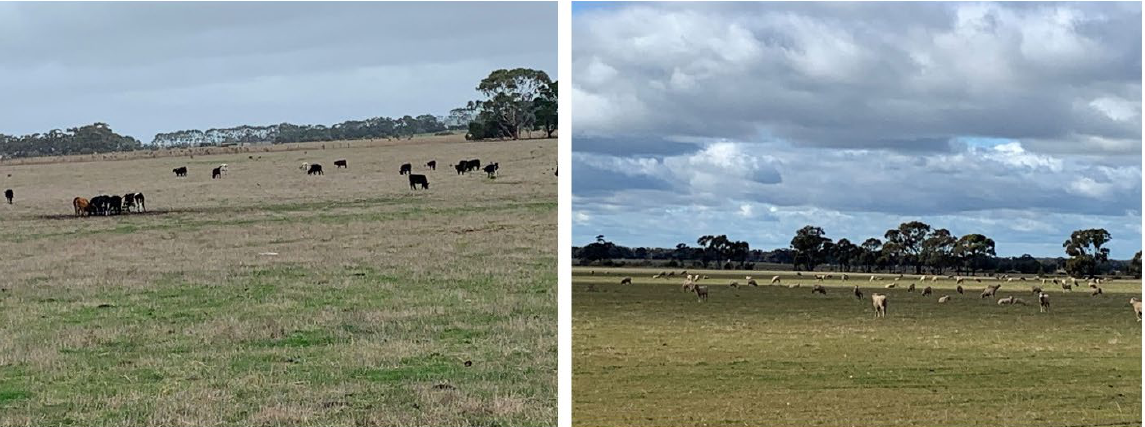
Figure 1. Feeding systems offer marginal amounts of antioxidants for daily maintenance and per- formance where the commencement of supplementary feeding with diets containing vitamins and minerals such as silage and/or a mix of grain is necessary for better health and productivity of animals. Cattle and sheep were grazing perennial ryegrass during autumn (April) 2021 and winter (July) 2022 seasons in the Western and Northern regions of Victoria, Australia.